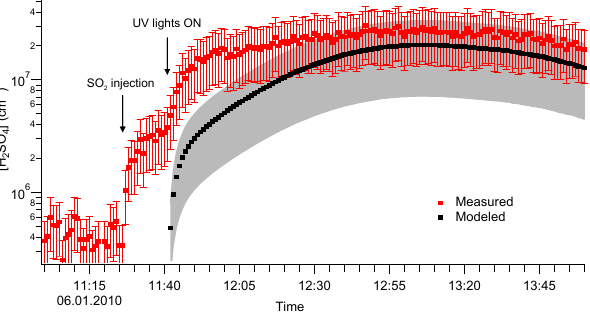
Fig. 5. Measured sulfuric acid time evolution during TMB 1 experi- ment (red markers) and modeled sulfuric acid concentration (black) obtained with the kinetic model reported by Metzger et al. (2010). Uncertainties are estimated to be 50% on sulfuric acid (red error bars) and 65% on modeled data (gray shadow, see Metzger et al., 2010). Injection of SO 2 in the chamber produced an increase in the background concentration of sulfuric acid which was not included in the model used by Metzger et al.